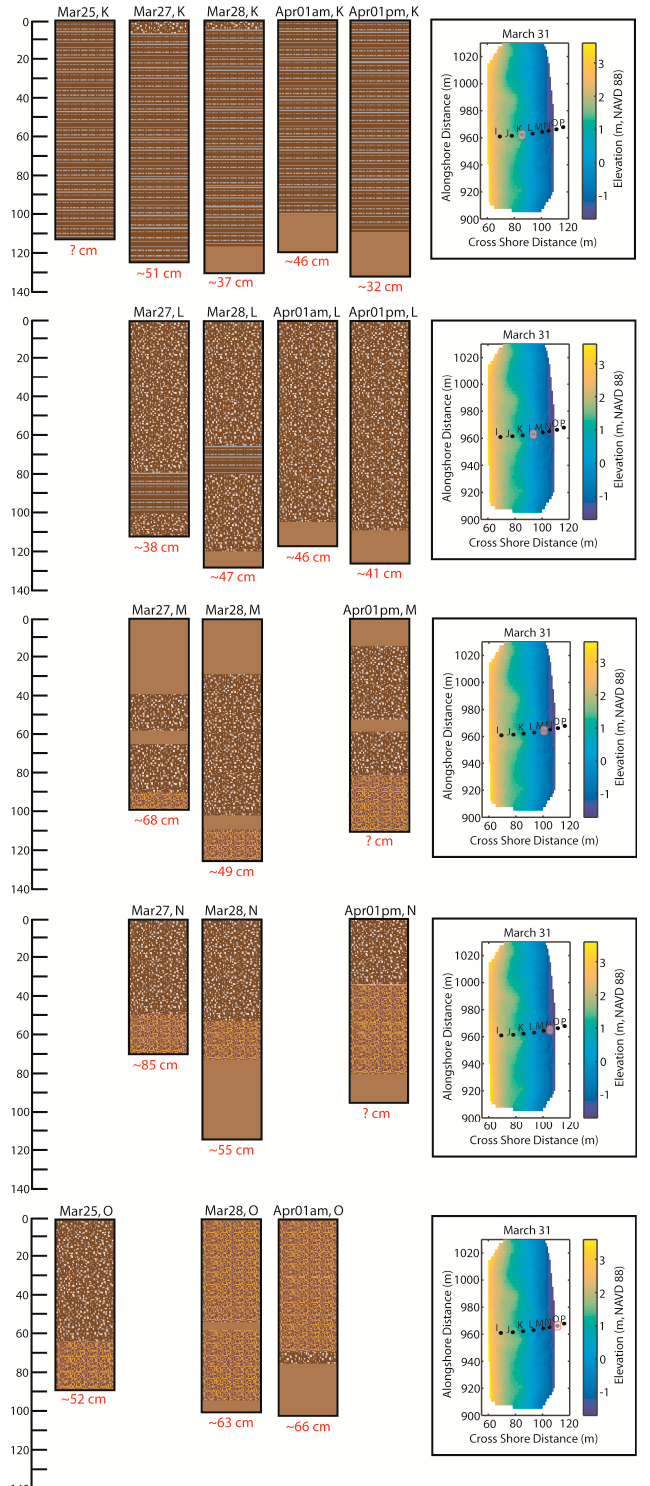
Figure 5. Cores described using their sedimentary units at five cross-shore locations (top to bottom: maps on the right show specific location), and for the five different sampling days/times (left to right). See Figure 4 for definition of the sedimentary units. Scale on the left is depth in the core in cm and red numbers indicate measured compaction.